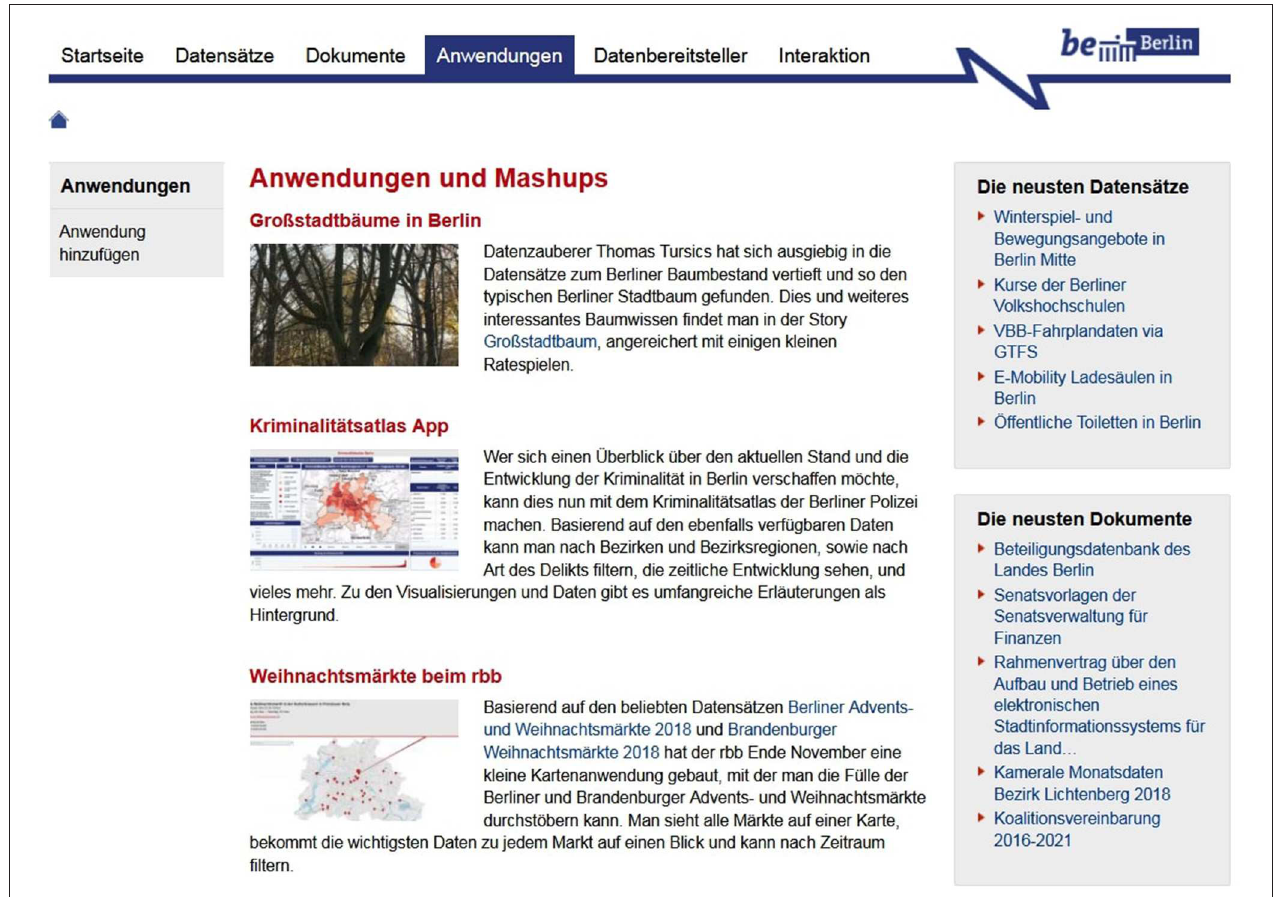
FIGURE 1 | A Screenshot of Berlin’s Open Data Portal depicting apps on trees, crime and Christmas markets in Berlin.